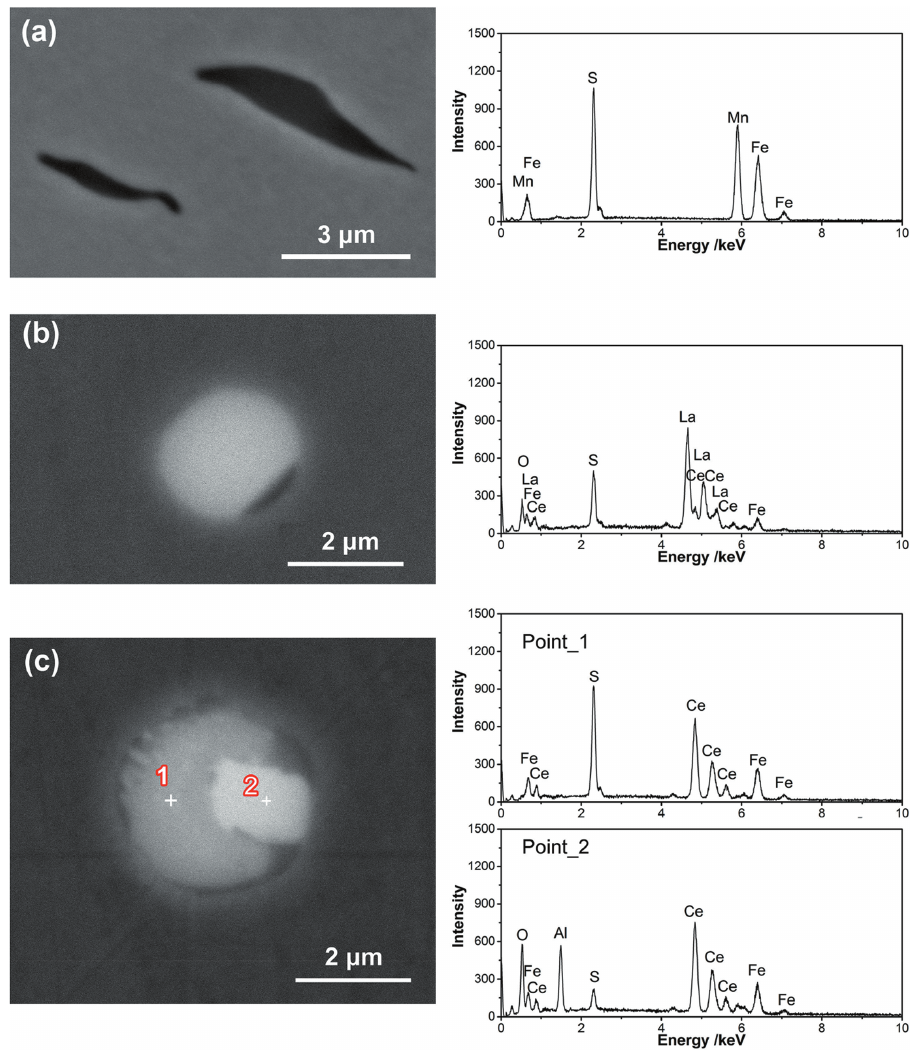
Figure 4: The morphology and composition of the inclusions in the experimental steels, (a) steel No.1; (b) steel No.2; (c) steel